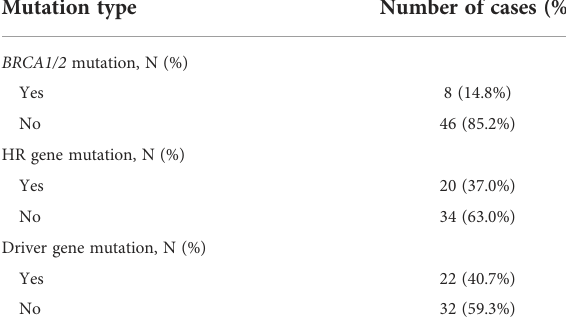
TABLE 2 HR gene and driver gene mutation information of 54 NSCLC